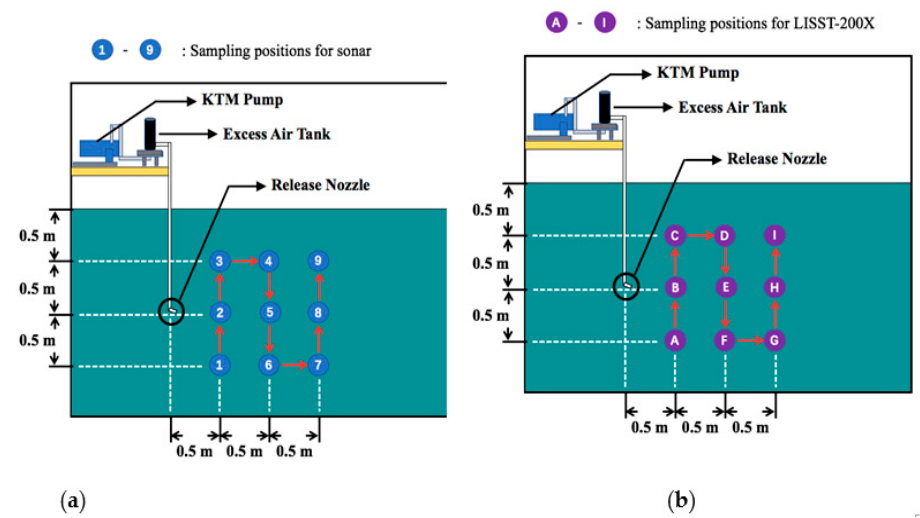
Figure 8. Side view of the sampling positions for ( a ) sonar and ( b ) LISST-200X in the tow tank.